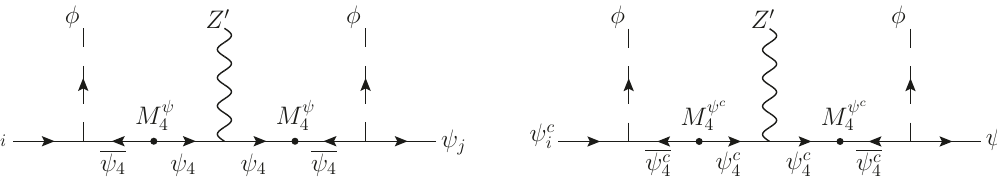
Figure 7 . Mass insertion approximation diagrams which lead to the e(cid:11)ective Z 0